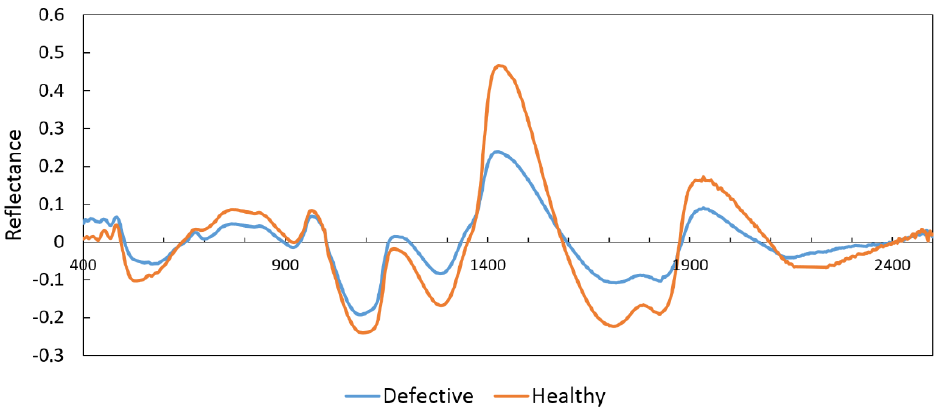
Figure 5. Two sample spectra of healthy and internal-defective potatoes at 400–2500